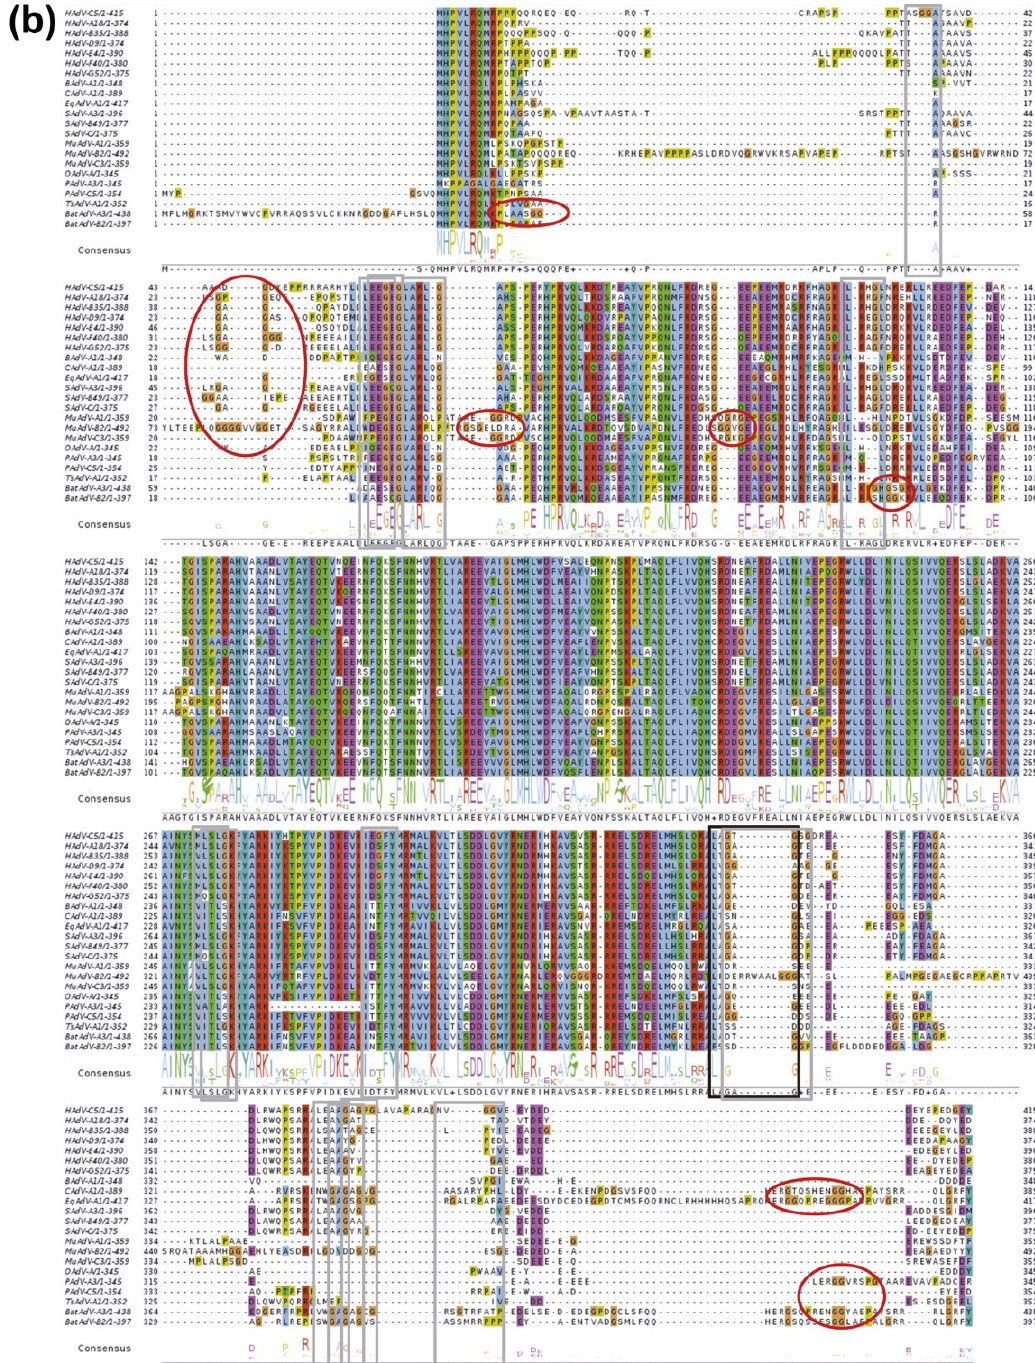
Figure 2. Conservation of AVP cleavage sites in the L1 52/55k protein. ( a ) Conservation across human AdV species; ( b ) Conservation across mastadenovirus species. Sequences were downloaded from GenBank and aligned with TCoffee [70]. The figure was created using JalView [71]. HAdV: human adenovirus; BAdV: bovine adenovirus; CAdV: canine adenovirus; EqAdV: equine adenovirus; SAdV: simian adenovirus; MuAdV: murine adenovirus; OAdV: ovine adenovirus; PAdV: porcine adenovirus; TsAdV: tree shrew adenovirus; BatAdV: bat adenovirus. Black frames indicate the AVP consensus cleavage site in HAdV-C2 L1 52/55k; gray frames indicate non-consensus sites described in [60]; red ovals indicate Gly stretches that could be possible additional cleavage